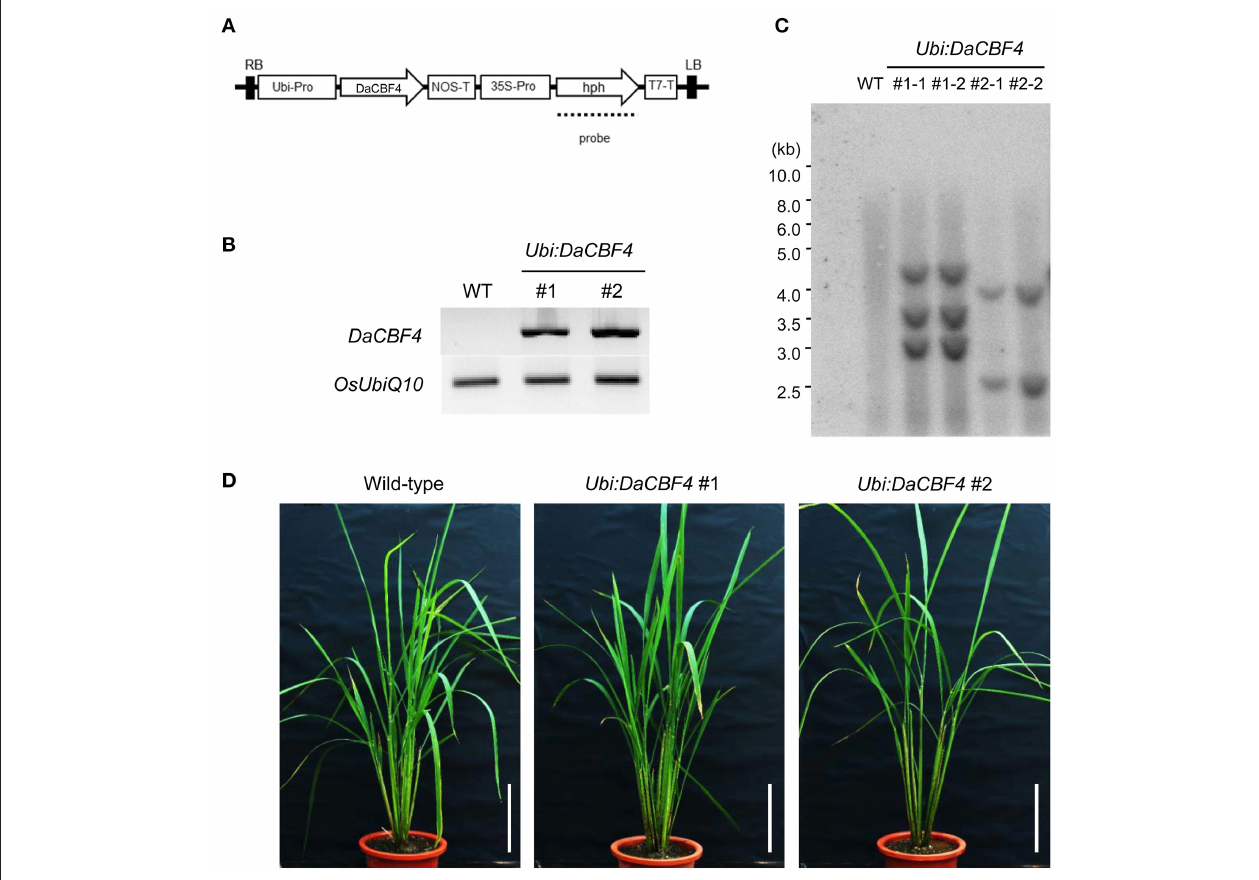
FIGURE 3 | Generation and molecular characterization of Ubi:DaCBF4 transgenic rice plants. (A) Schematic representation of the binary vector construct used for DaCBF4 overexpression under the control of the maize ubiquitin promoter. RB, right border; Ubi-Pro, ubiquitin promoter; NOS-T, terminator sequence from nopaline synthase gene; 35S-Pro, CaMV 35S promoter; hph, hygromycin B phosphotransferase; T7-T, T7 terminator; LB, left border. (B) Semi-quantitative RT-PCR analysis of 6-week-old wild-type and two independent Ubi:DaCBF4 T2 transgenic plants (lines #1 and #2). (C) Genomic Southern blot analysis. Total leaf genomic DNA was isolated from wild-type and T2 Ubi:DaCBF4 transgenic rice plants. DNA was digested by Bam HI and hybridized with 32 P-labeled hph probe under high-stringency conditions. (D) Overall morphology of 2-month-old wild type and T2 Ubi:DaCBF4 transgenic (independent lines #1 and #2) rice plants. Rice plants were grown under greenhouse conditions. Scale bars =